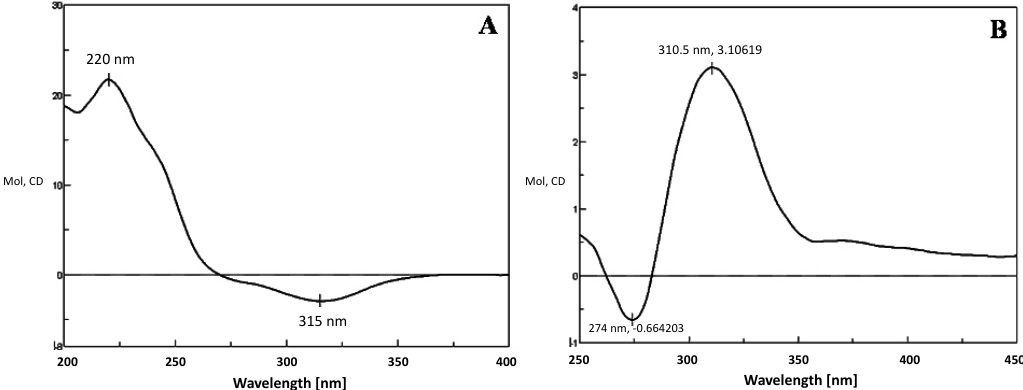
Figure 5. CD spectrum of 16 β -OH-MT without Mo 2 (OAc) 4 ( A ) or mixed with Mo 2 (OAc) 4 ( B